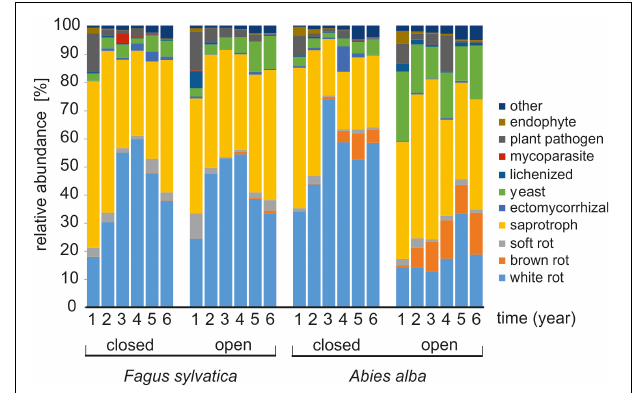
FIGURE 4 | Diversity of fungal ecophysiological groups in fine beech ( Fagus sylvatica ) and fir ( Abies alba ) deadwoods decomposing in a natural temperate forest. Data represent means from 16 samples from 4 sampling